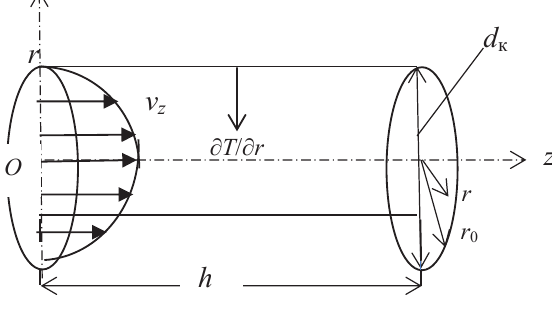
Figure 1 Scheme of liquid cooling with frozen balls